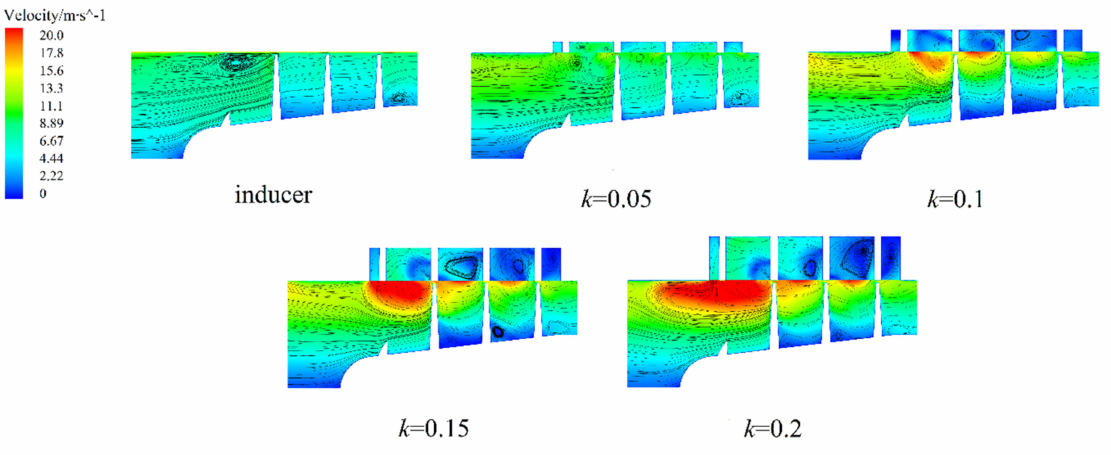
Figure 8. Velocity and streamline distribution under different radial